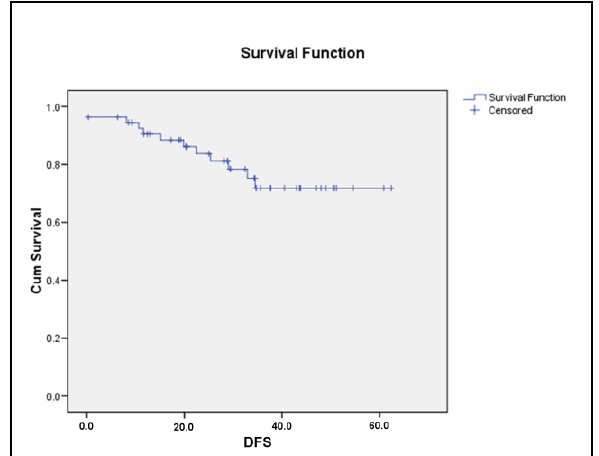
Figure 2: Kaplan-Meier curve of estimated disease- free survival of M0 patients